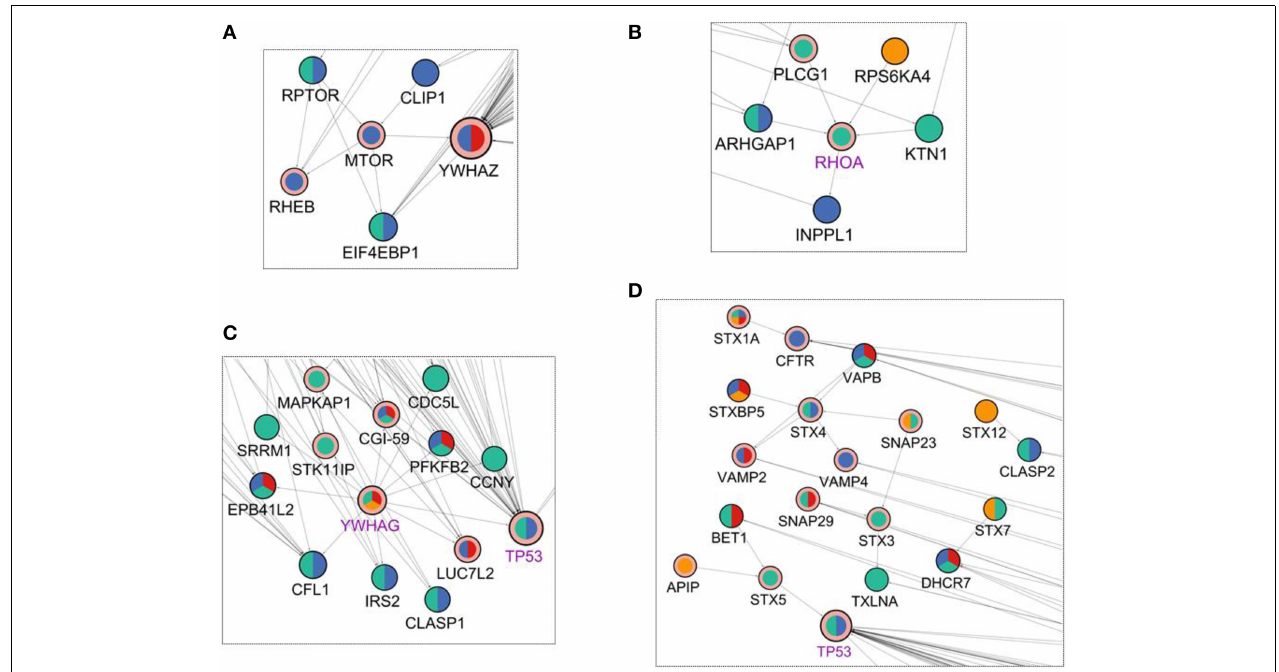
FIGURE 4 | Visualization of the first degree neighbors of (A) mTOR, (B) RHOA, (C) YWHAG, and (D) Syntaxins in the reconstructed network in Figure 2. The coloring scheme is the same as in Figure 2